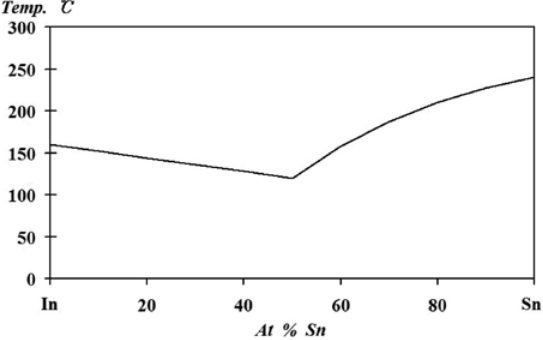
107 Binary system of indium and tin showing the eutectic tempera- ture of about 120 ℃